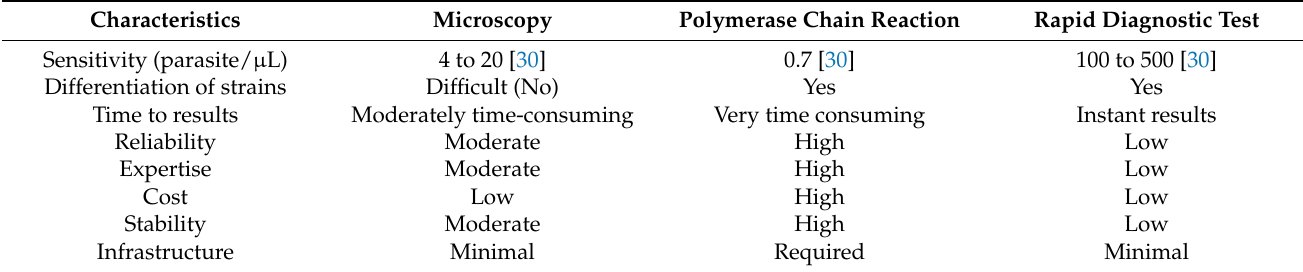
Table 1. Comparison of the gold standard and widely used malaria diagnostic tools across the world.